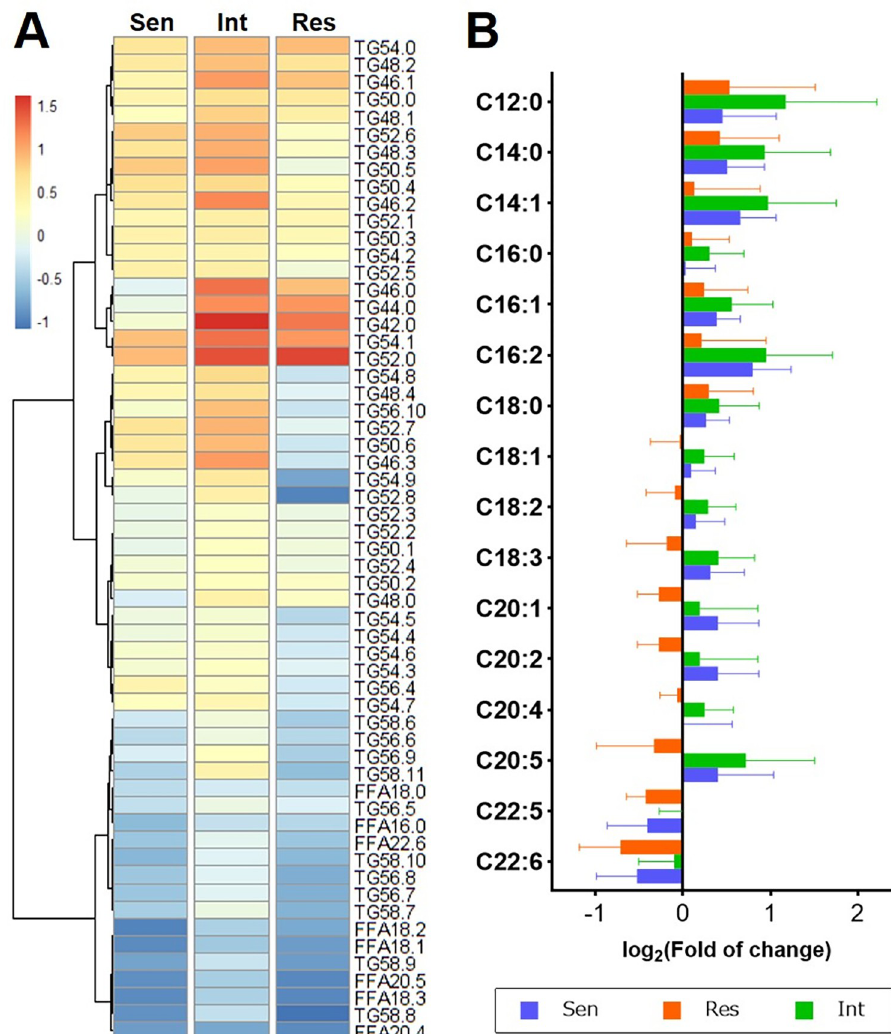
Fig 5. (A) Heatmap for the relative changes of TG and FFA species during KD treatment. (B) Changes of each fatty acyl in TG for Sen (blue), Int (green), and Res (red) groups between the before- and after-treatment